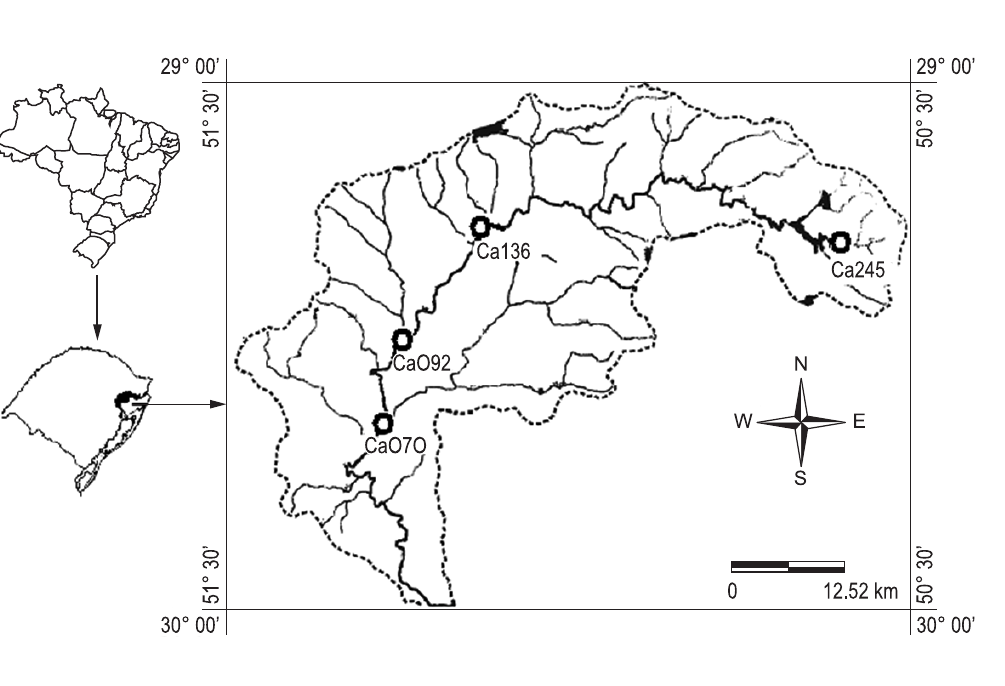
Figure 1. Location of the study site in Brazil, Rio Grande do Sul state, Caí River basin. Sites Ca245, Ca136, Ca092 and